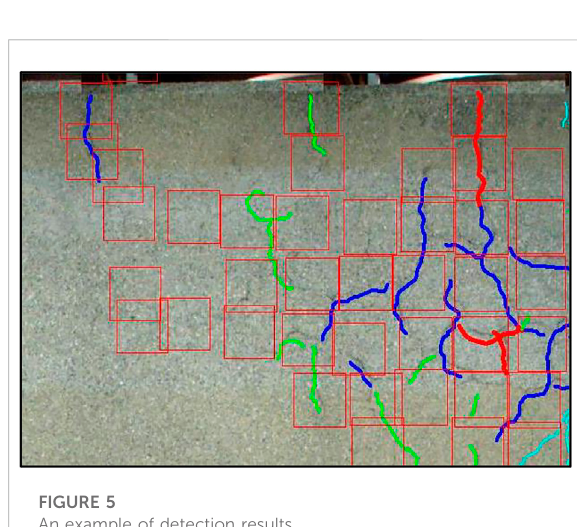
FIGURE 5 An example of detection